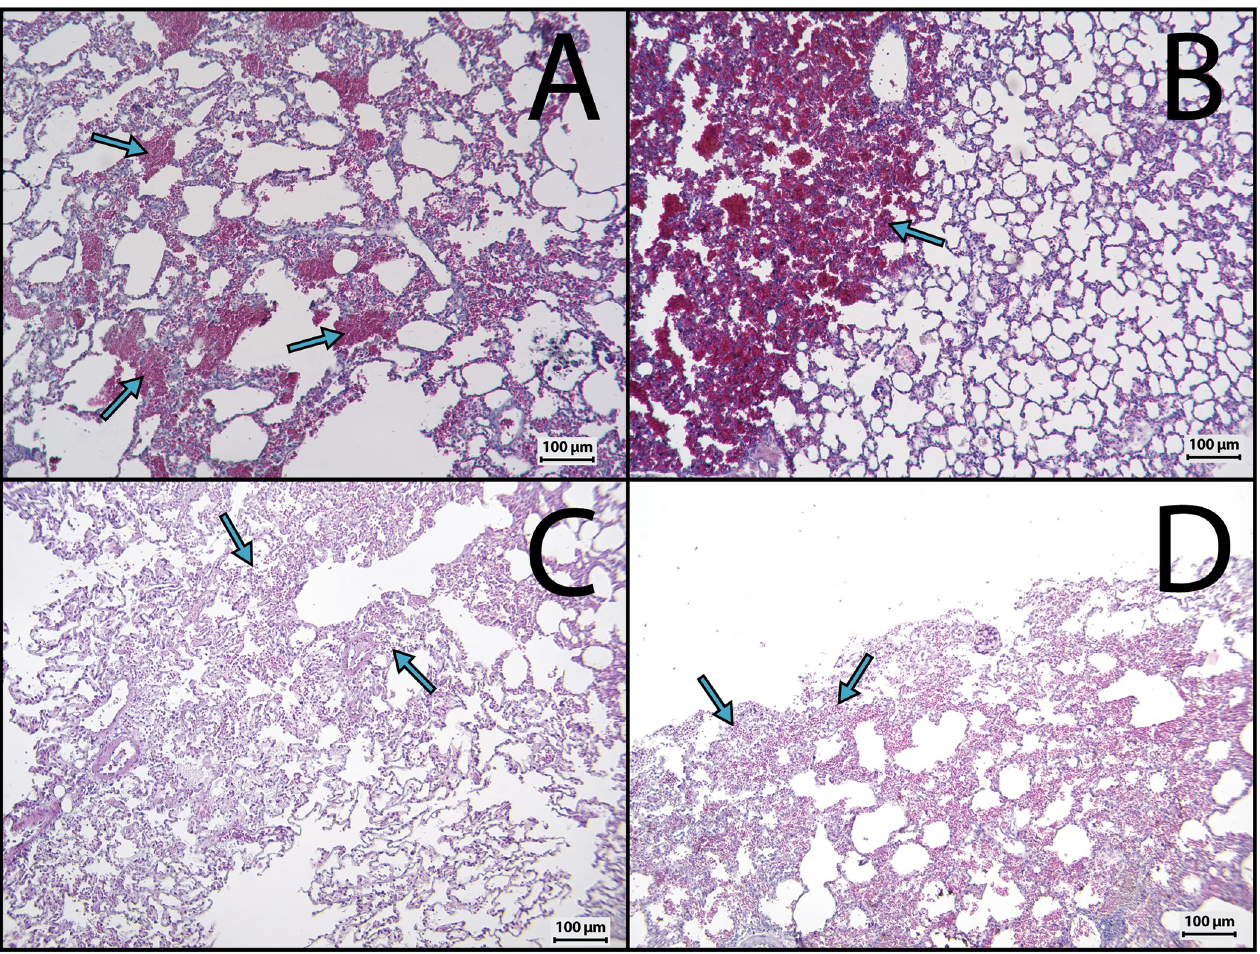
Fig 2. Histological alterations in lungs induced by Bitis spp and Echis spp venoms in rabbits. Immediately after euthanasia, lung samples were collected from rabbits immunized with venoms, and added to 3.7% formalin solution. After embedding the samples in paraffin, sections of 4 μ m of thickness were obtained and stained with hematoxylin-eosin. Light micrographs correspond to sections obtained from rabbits immunized with the venoms of B . arietans (A), B . gabonica (B), E . coloratus (C) and E . ocellatus (D). Arrows depict areas with extravasated erythrocytes. Bar corresponds to 100 μ m.